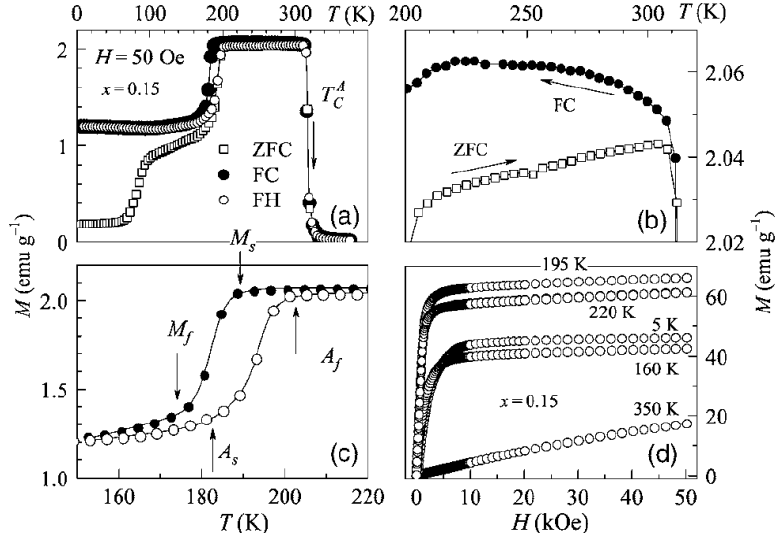
Figure 20. ( a – d ) Temperature-dependent magnetization (M(T)) and magnetic-field-dependent magnetization (M(H)) curves of Ni 0.50 Mn 0.35 Sn 0.15 alloy [130], with copyright permission from © IOP Publishing .